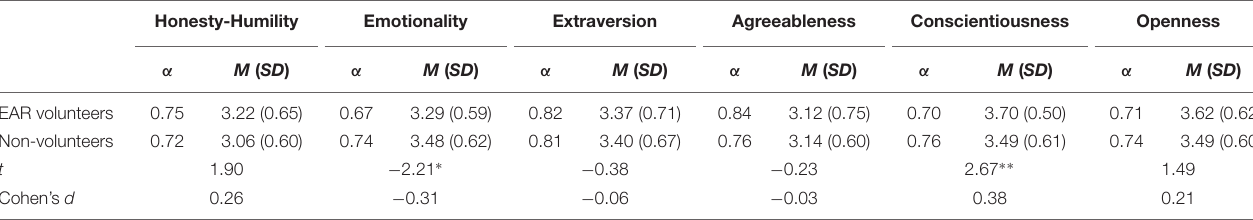
TABLE 2 | HEXACO dimension scale reliability and scores of EAR volunteers and non-volunteer comparison